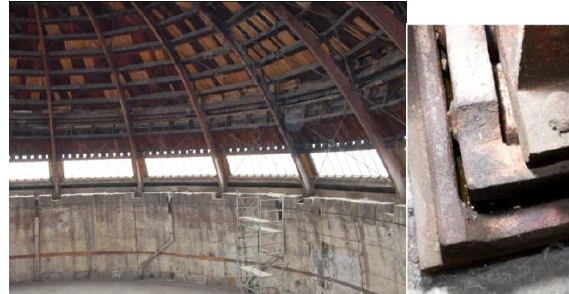
Figure 6. Places carriages on the perimeter wall and detail of support device